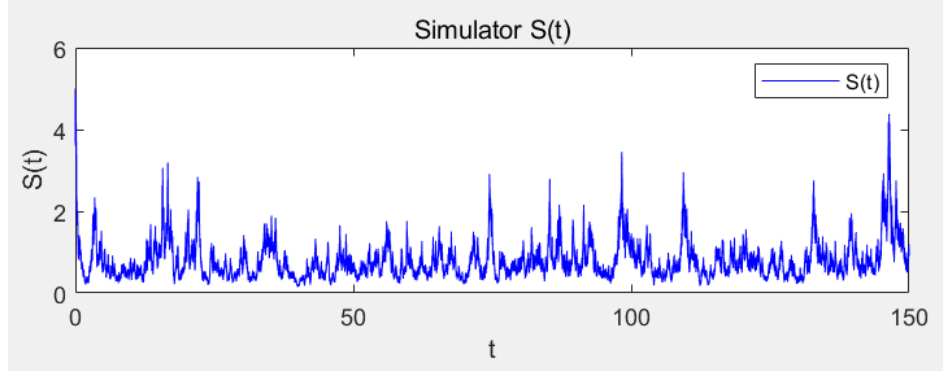
Figure 14. Sample path of S(t).